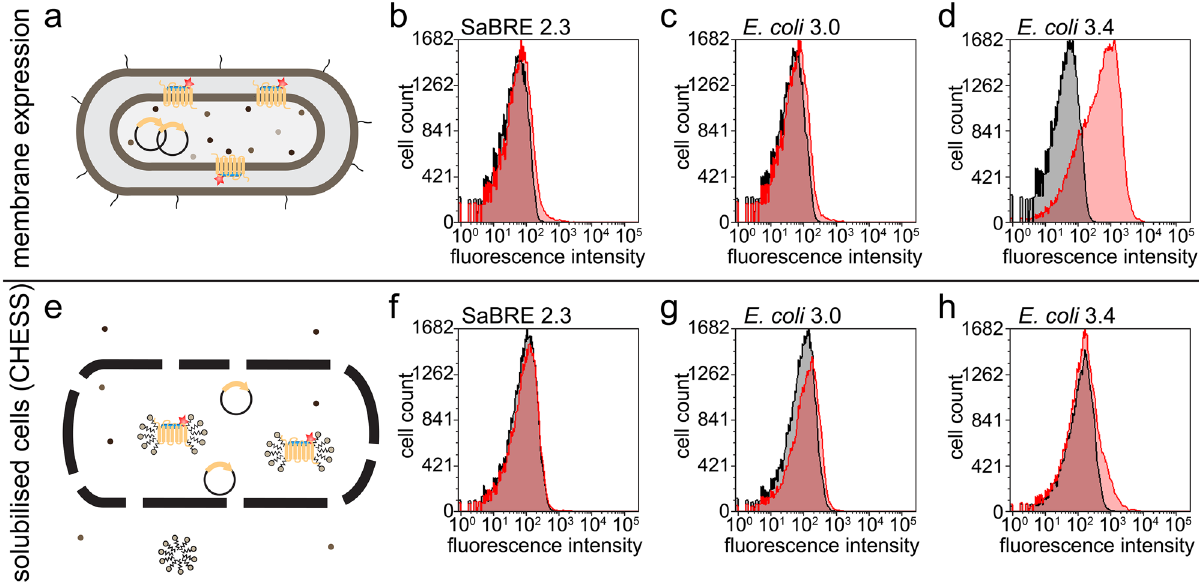
Figure 2. Selection for high functional expression and detergent stability in E. coli. ( a ) Schematic representation of the probing with fluorescently labelled (red star) ligand (blue rod) for well-expressing OTR variants (yellow rods) in the membrane of intact E. coli cells. ( b , d ) Histogram plots of flow cytometry detecting binding of fluorescent ligand on intact E. coli cells. Total signal (red curves) and nonspecific signal (black curves) are shown for the pools SaBRE 2.3 ( b ) E. coli 3.0 ( c ) and E. coli 3.4 ( d ), expressed in E. coli . ( e ) Schematic representation of a polymer-encapsulated (black lines) E. coli cell, whose internal space is subsequently solubilised with detergent, as performed in CHESS, converting the cells essentially to nanoscopic dialysis bags. ( f , h ) Histogram plots of flow cytometry detecting binding of fluorescent ligand within polymer capsules. Total signal (red curves) and nonspecific signal (black curves) are shown for the pools SaBRE 2.3 ( f ) E. coli 3.0 ( g ) and E. coli 3.4 ( h ), after E. coli expression,encapsulation and